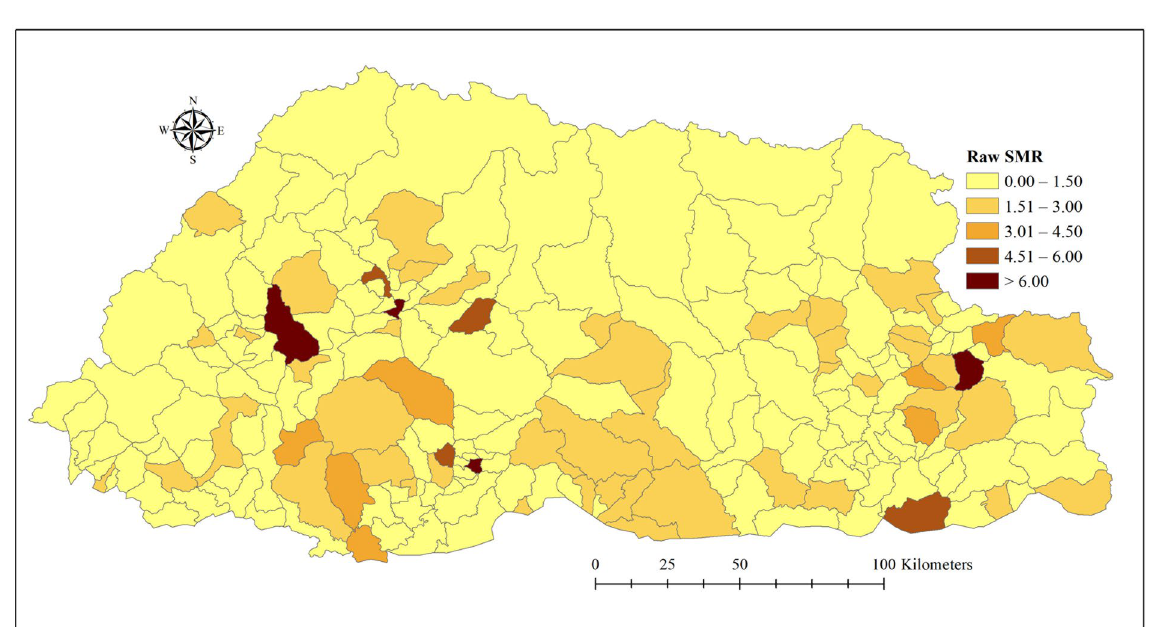
Figure 1. Raw standardized morbidity ratios (SMR) of the common cold by sub-districts in Bhutan, January 2010–December